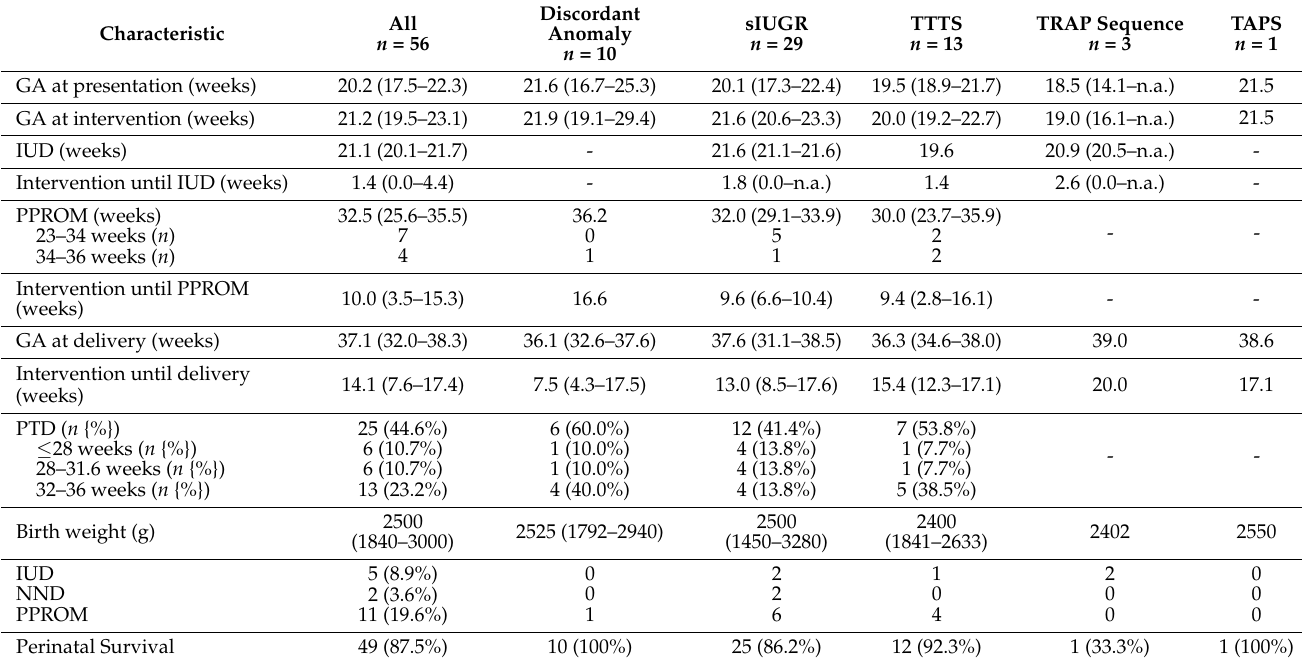
Table 2. Characteristics and outcomes of 56 cases after selective feticide, given in median (interquartile range (IQR),